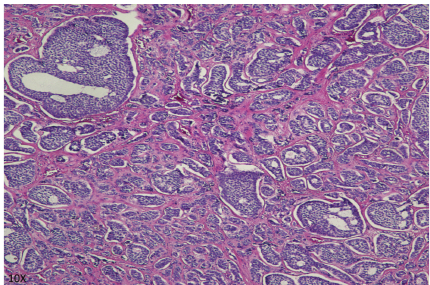
Figure 1: Axial image of an MRCP demonstrating the relevant anatomy of the tumor, vessels, and proximal pancreas, with the absence of the dorsal pancreas (white arrow). Outlines represent the pancreatic head and neck (yellow), the pancreatic neuroendocrine tumor (red), the superior mesenteric vein (purple), and the splenic vein (blue).